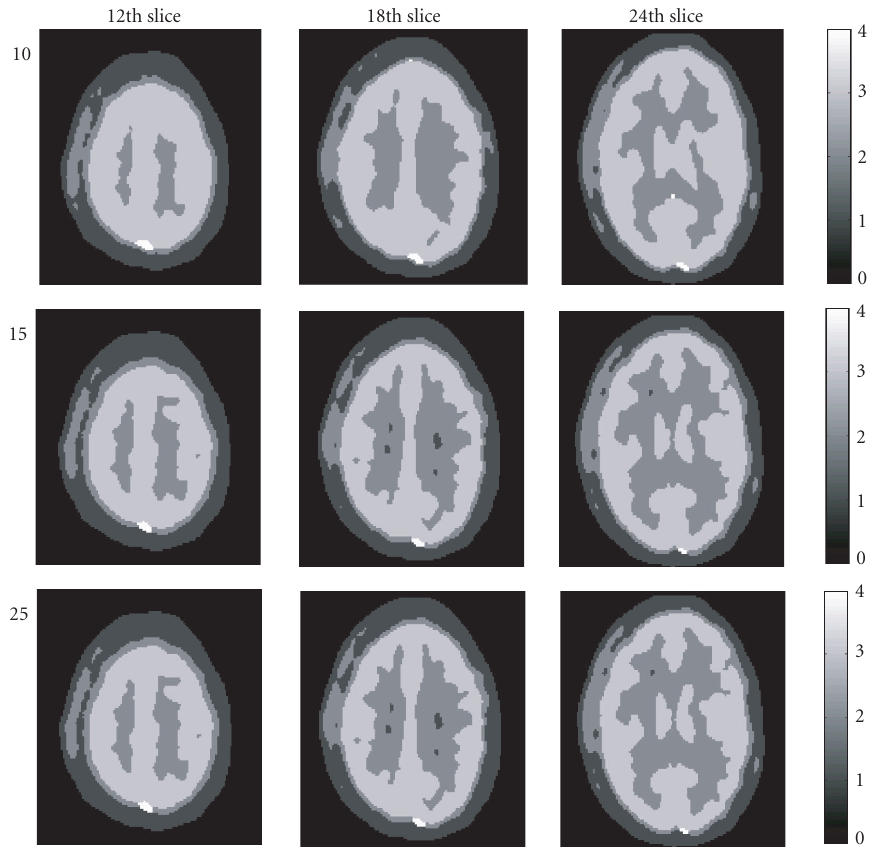
Figure 1: The 12th slice, 18th slice, and 24th slice of 3D PET dynamic data clustered image.